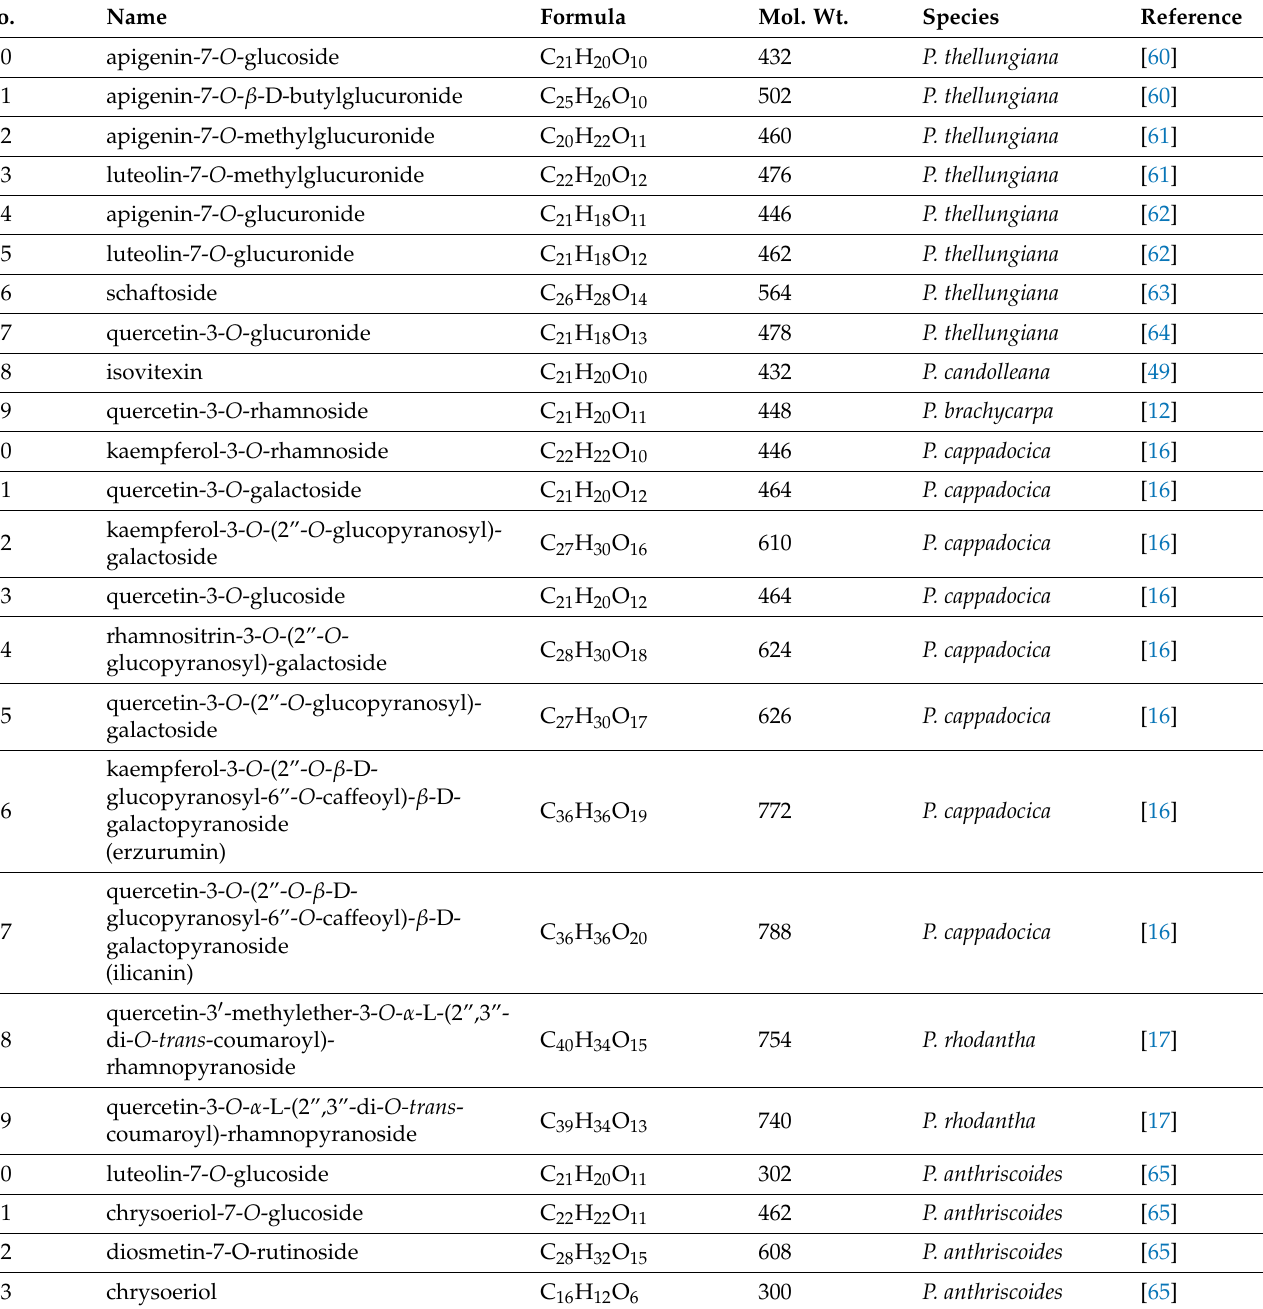
Table 4. Flavonoids and their glycosides of Pimpinella plants.